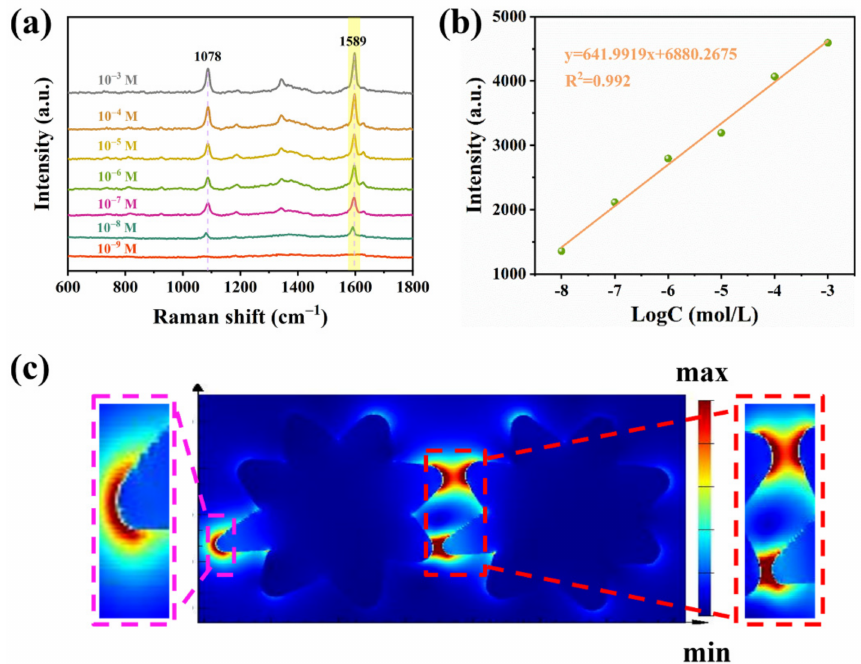
Figure 4. ( a ) SERS spectra of 4-MBA at various concentrations from 10 − 3 to 10 − 9 M, ( b ) corresponding plot of logarithmic concentration and SERS intensity of 4-MBA at 1589 cm − 1 , and ( c ) electric field distributions of adjacent